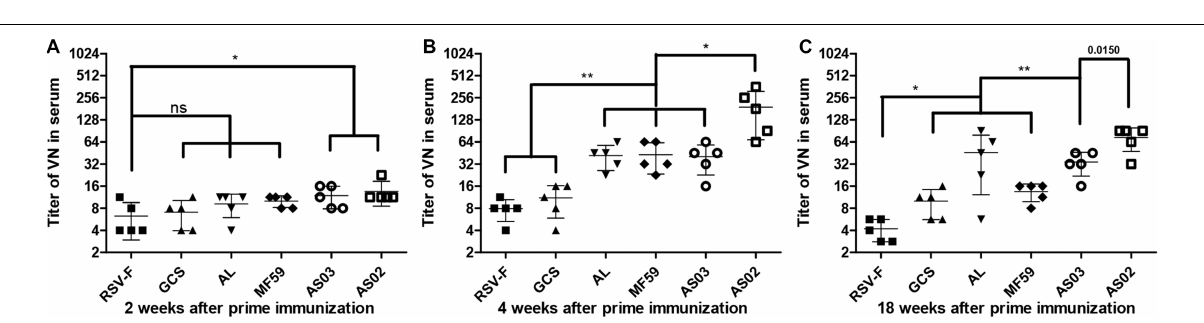
(FPKM) values were calculated for each sample.